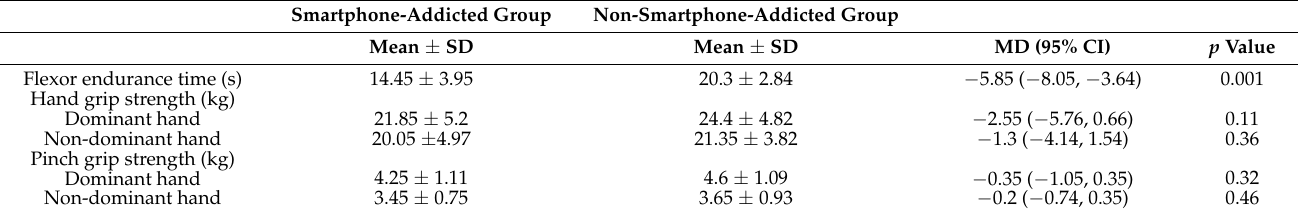
Table 2. Between-group comparisons of neck flexor endurance time, hand grip, and pinch strength. Smartphone-Addicted